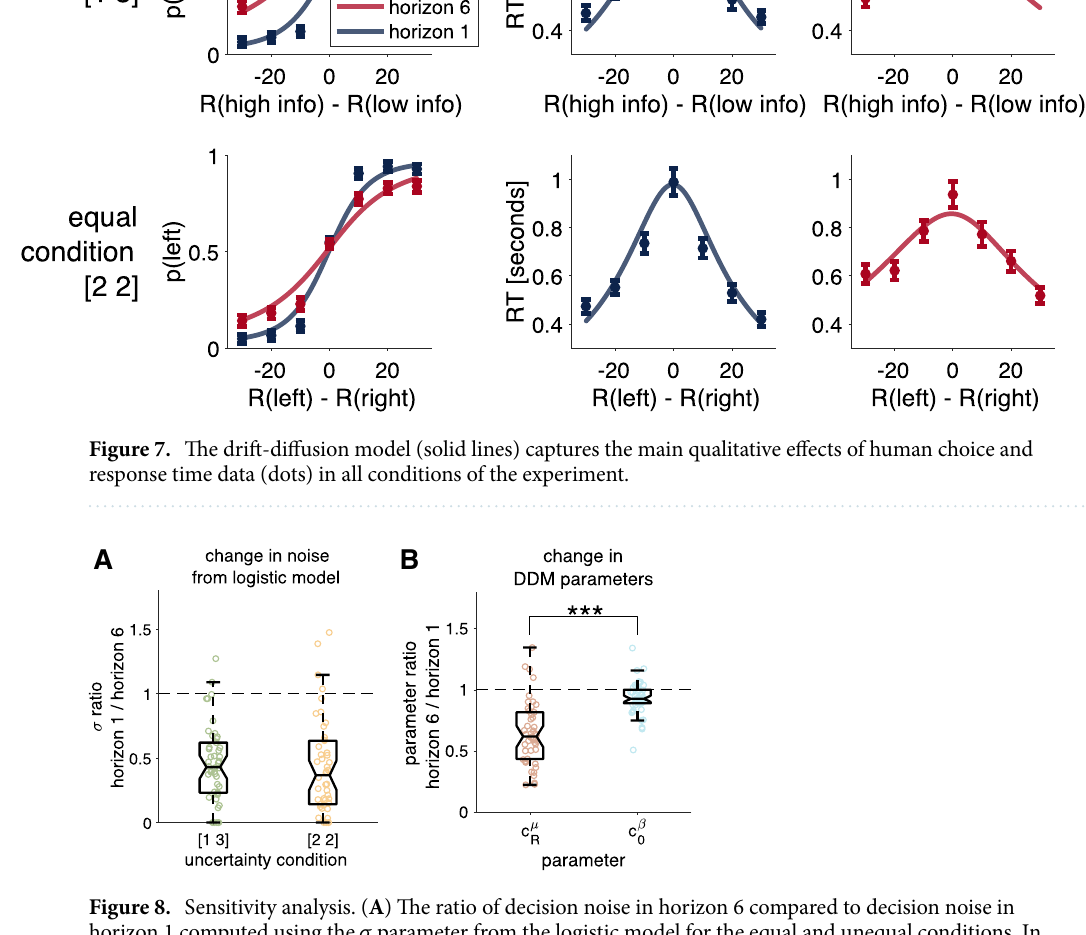
µ c β 0 , in horizon 1 to R and